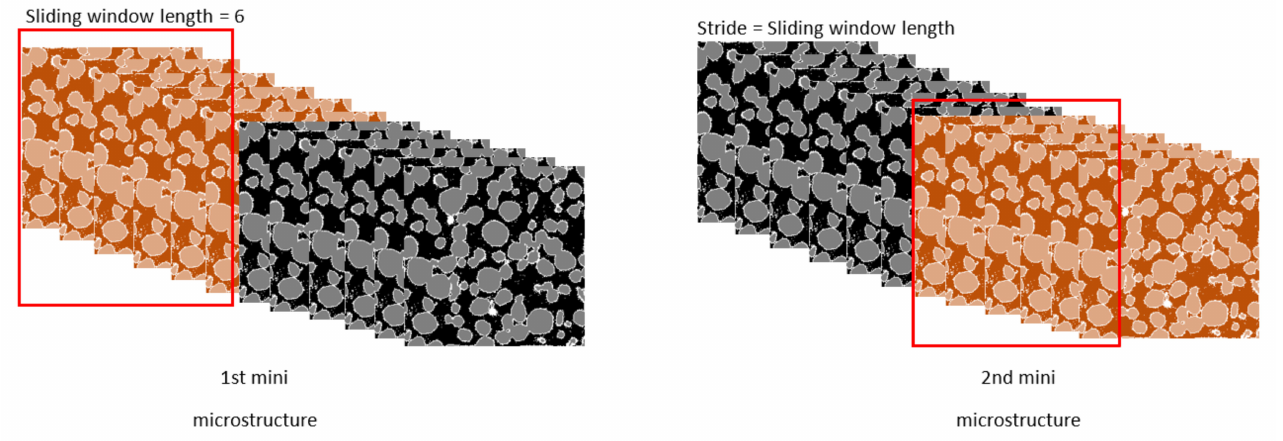
Figure 8. An example of transforming a microstructure into multiple 3D mini microstructures using a sliding window of length = 6 and stride = length of sliding